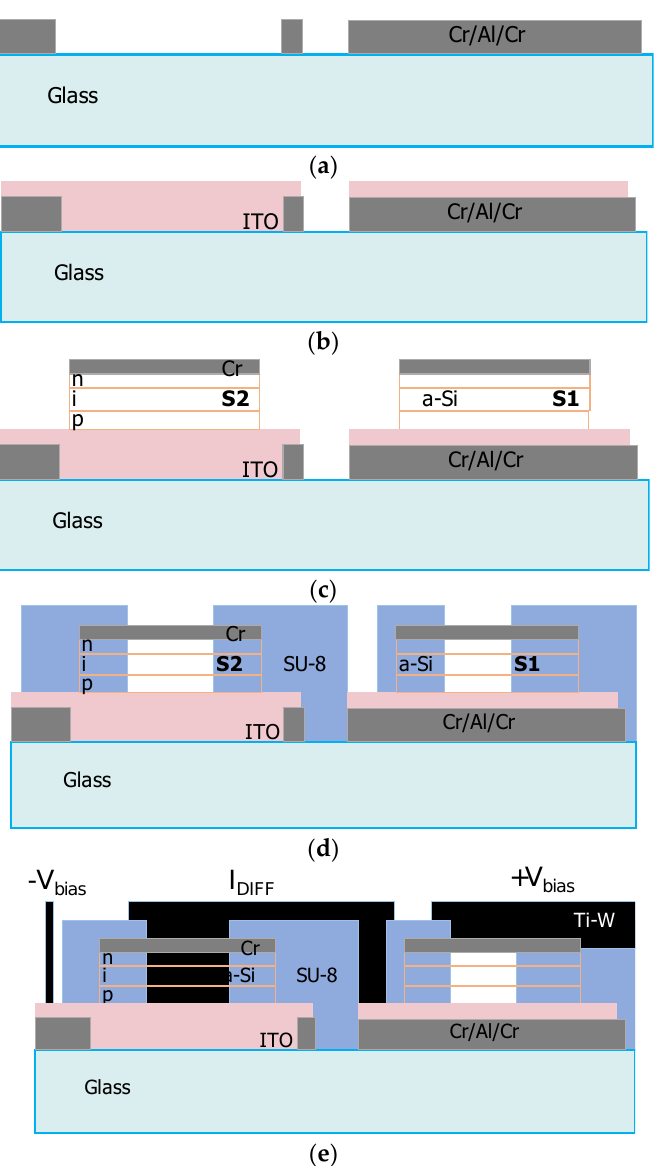
Figure 3. Fabrication flow of the differential device (see text for details), showing the deposition and patterning of the: ( a ) metal bottom contact; ( b ) Indium Tin Oxide (ITO) layer; ( c ) a-Si:H diodes; ( d ) SU-8 insulation layer; ( e ) top electrode.